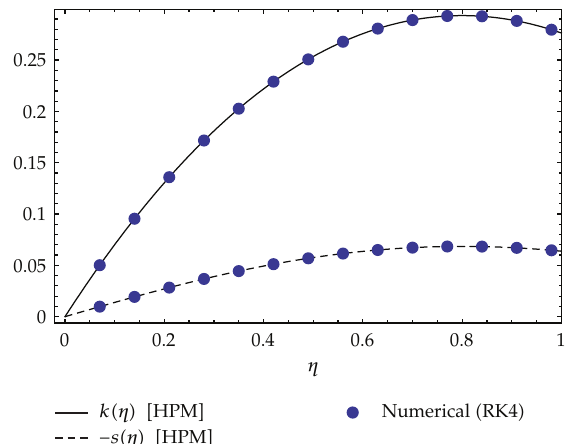
Figure 3: The normalized velocity profiles for the draining flow (cid:3) k (cid:3) η (cid:4)(cid:4) and lateral flow (cid:3) s (cid:3) η (cid:4)(cid:4) obtained by the 8th-order approximation of the HPM in comparison with the numerical solution, when δ (cid:7) 0 . 8. The net forces per unit area in the x and y directions, normalized by ρg k (cid:2) (cid:3) 0 (cid:4) and s (cid:2) (cid:3) 0 (cid:4) , respectively. Figure 5 shows these quantities. The normalized temperature profiles for di ff erent values of the Prandtl number are represented in Figure 6. The value of θ (cid:2) (cid:3) 0 (cid:4) represents the local heat transfer on the disk normalized by k (cid:3) T 0 − T w (cid:4) k is the thermal conductivity. We show θ (cid:2) (cid:3) 0 (cid:4) for di ff erent values of the Prandtl number in Figure 7. The Nusselt number is defined